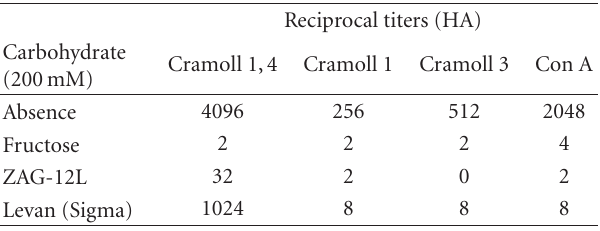
Figure 2: A ffi nity binding of Con A on FMZAG-12L . An amount of 1.5 mg of Con A was incubated with the magnetic particles and firstly eluted with bu ff er and glucose afterwards (arrow). Fractions (1mL) were collected and their absorbance at 280 nm established. Each bar represents the mean ± SD of four experiments using the same FMZAG-12L particles.